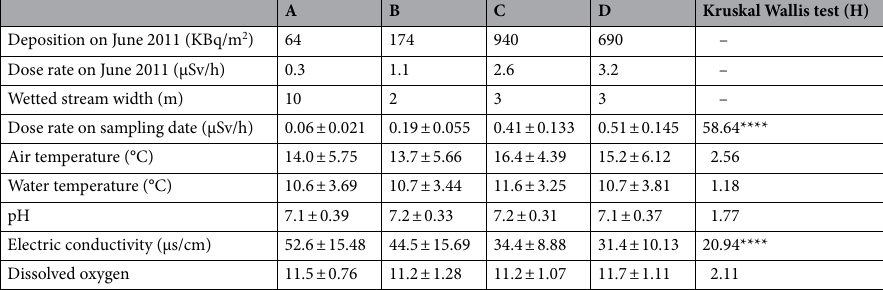
Table 1. Air dose rate and the deposition of Cs according to an aircraft radioactivity survey by MEXT (2011), averaged value of dose rate 1-m above the ground on the sampling date from 2013 to 2019 (n = 23) and five environmental factors on four sites on the sampling date from 2013 to 2019 (n = 23). **** P <